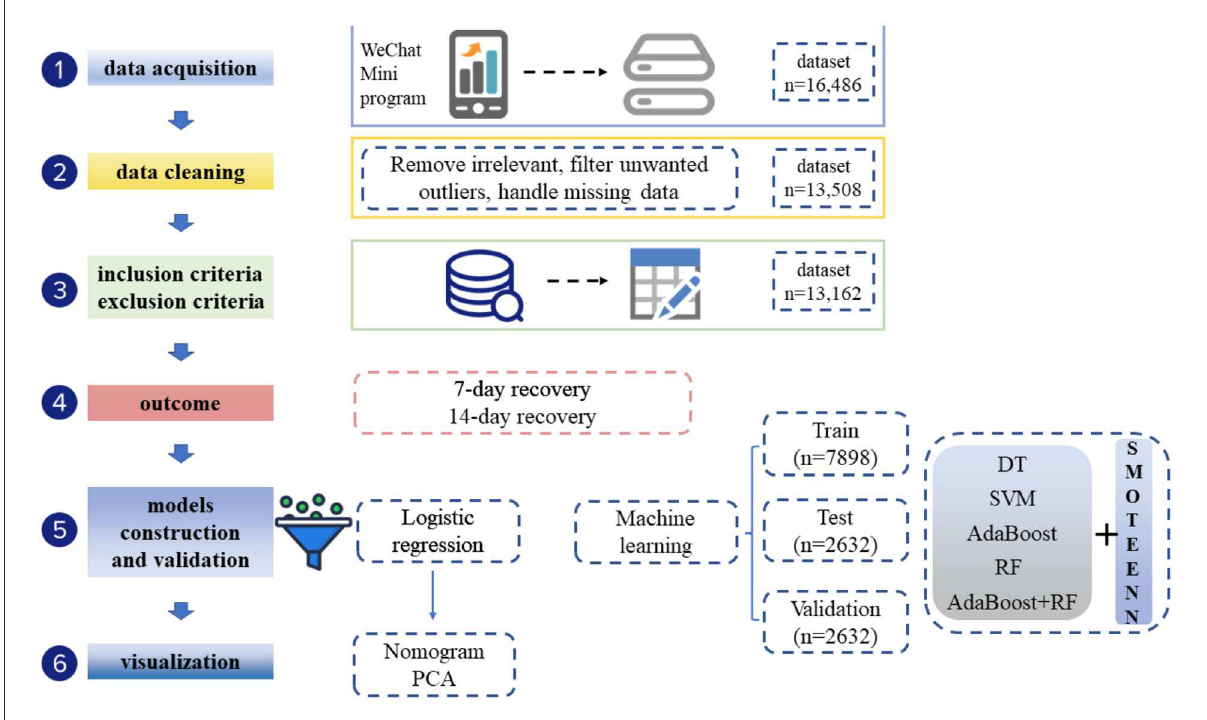
FIGURE1 Flow chart of participant selection and the study